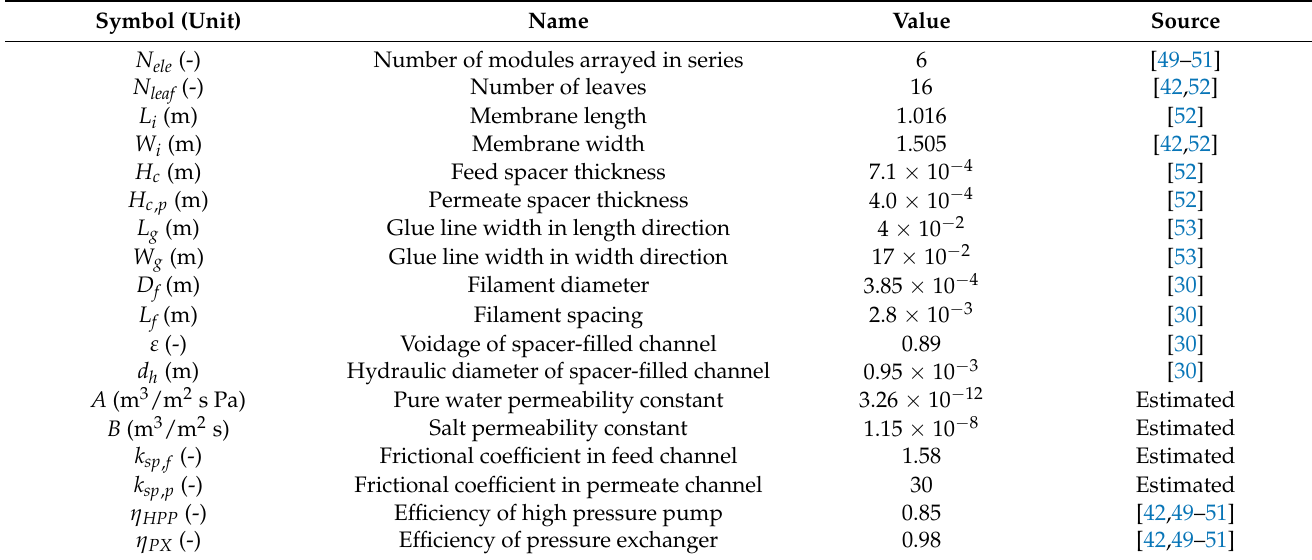
Table 2. List of parameters for RO process